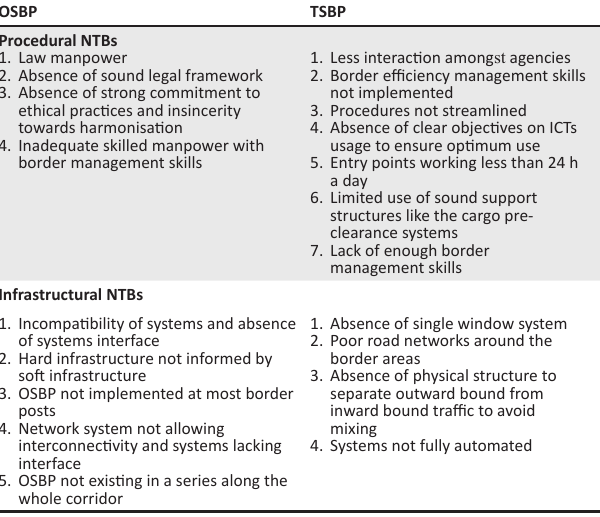
TABLE 2: Procedural and infrastructural non-tariff barriers on entry points. OSBP